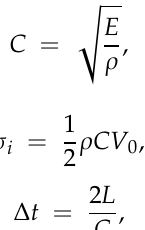
Figure 1. Split Hopkinson Pressure Bar device.